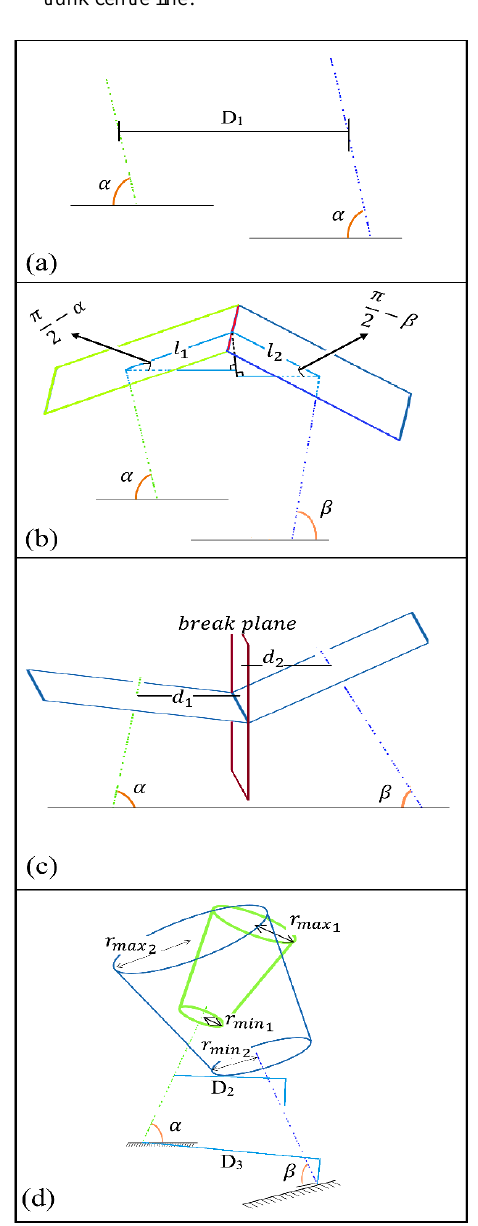
Figure 6. Visual expression of equations parameters: (a) trees are parallel, (b) trees are getting away from each other and (c and d) trees are approaching to each